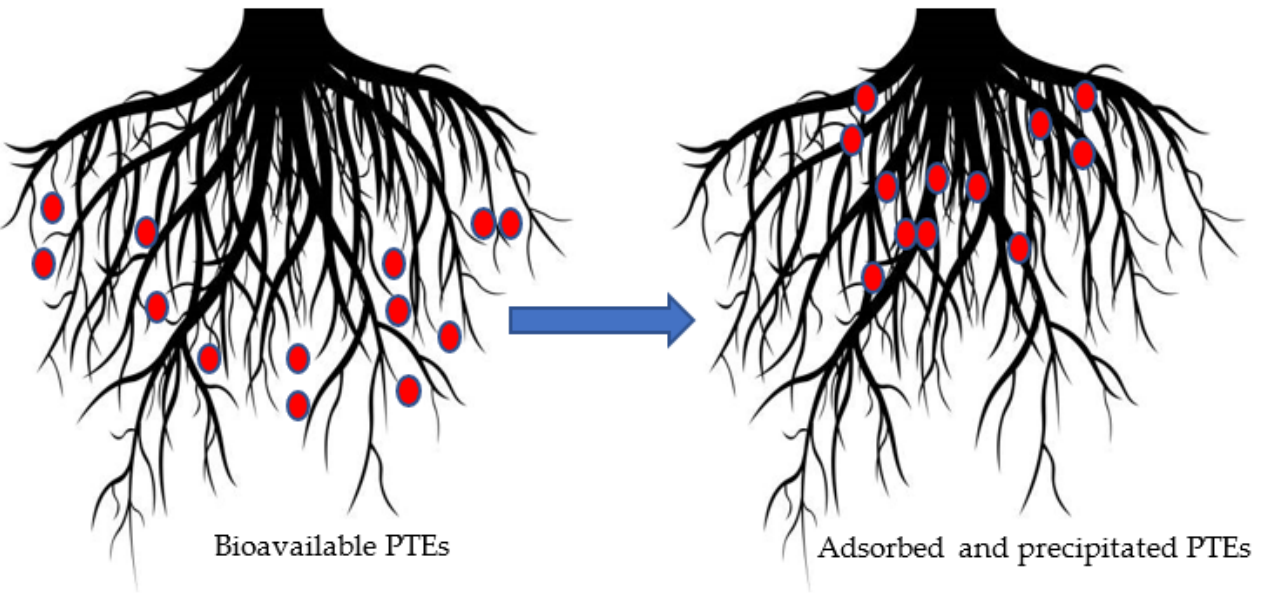
Figure 5. Mechanism underlying rhizofiltration